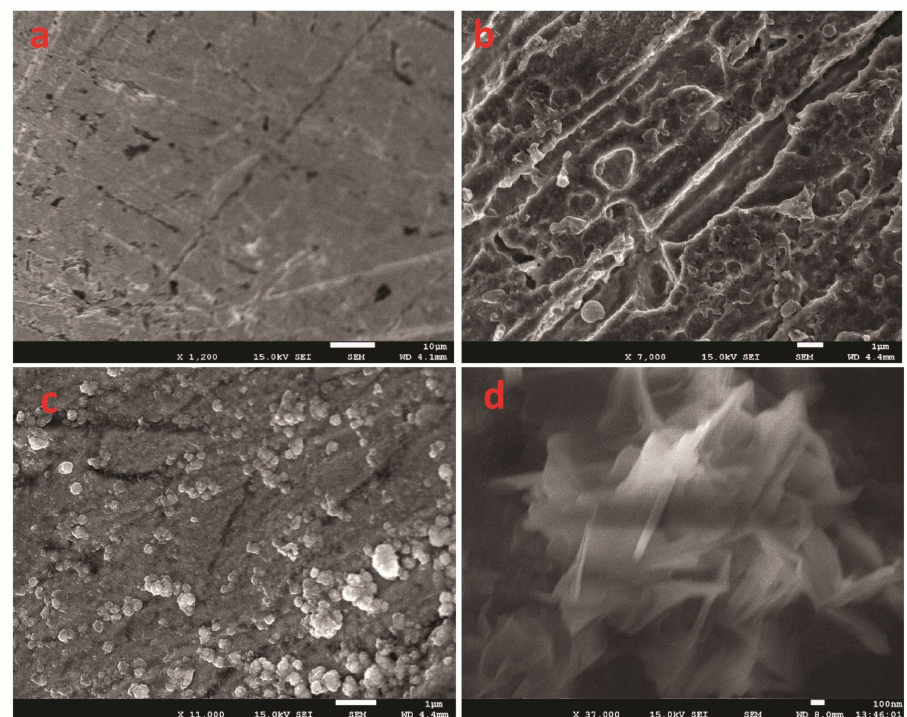
Figure 2. ( a ) Image of unmodified GCE (before electropolymerization). ( b ) Image of deposited PANI of GCE surface. ( c ) Image of PANI@MnBaO 2 (low magnification). ( d ) Focus on MnBaO 2 nanostructure (high magnification).